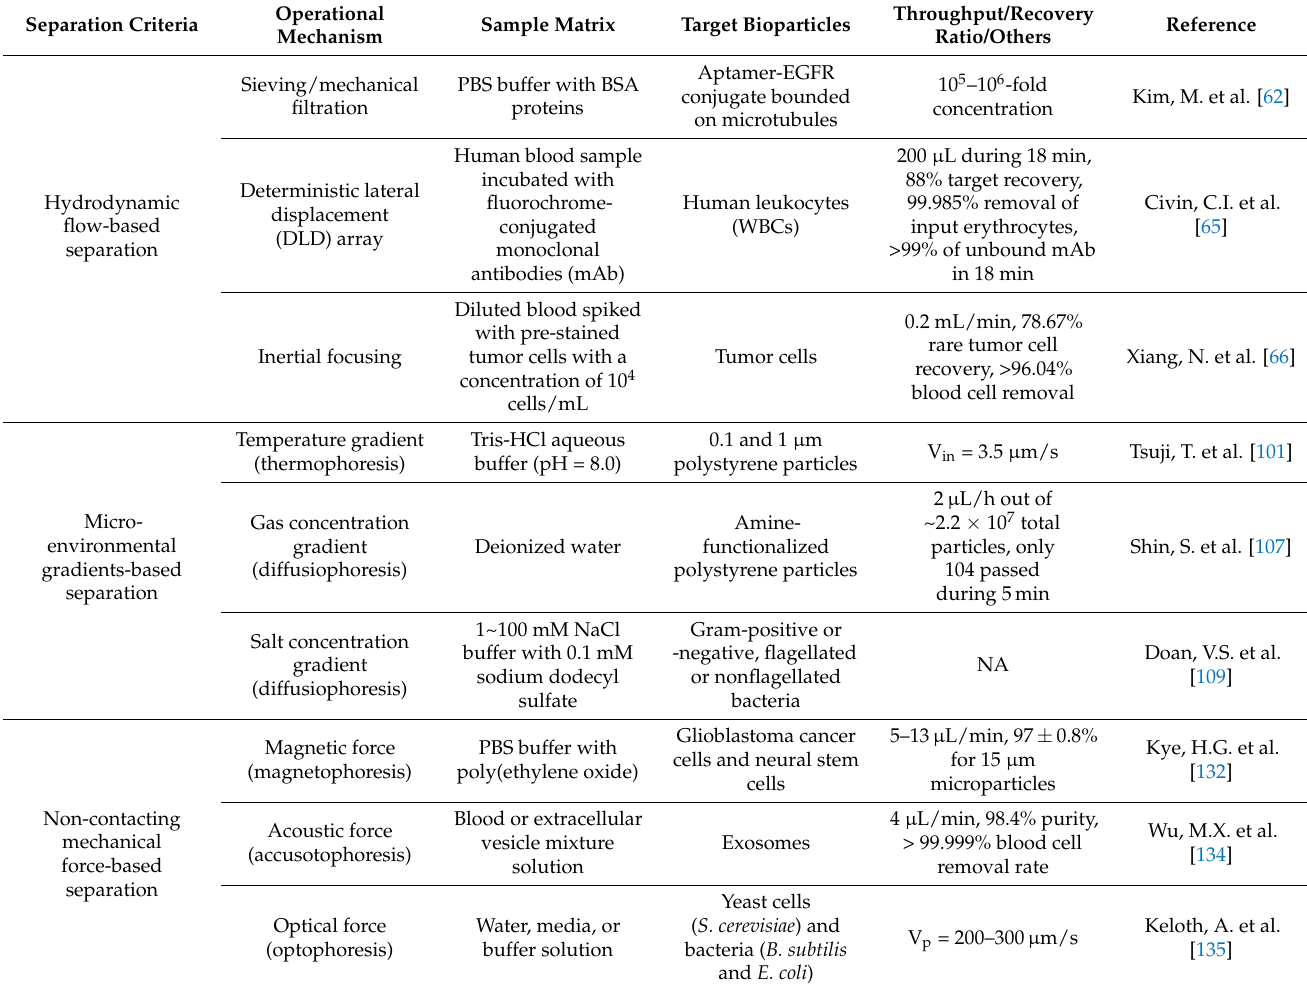
Table 1. Summary of microfluidic separation techniques for separation of various types of bioparticles. Separation